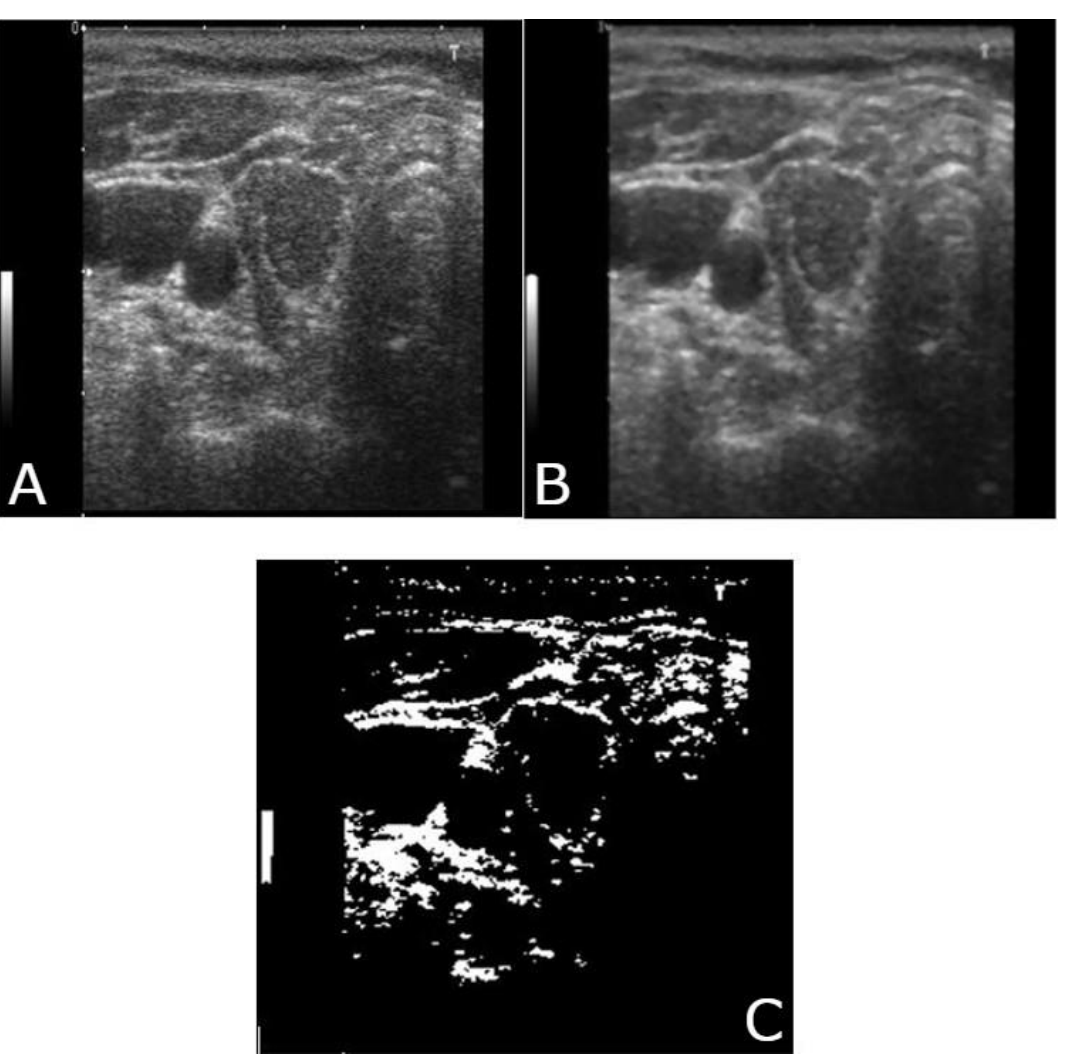
Figure 11. ( A ) Original image (malignant)-Top Left; ( B ) median filtered image (malignant) Top Right; ( C ) binary segmentation-Center Bottom.